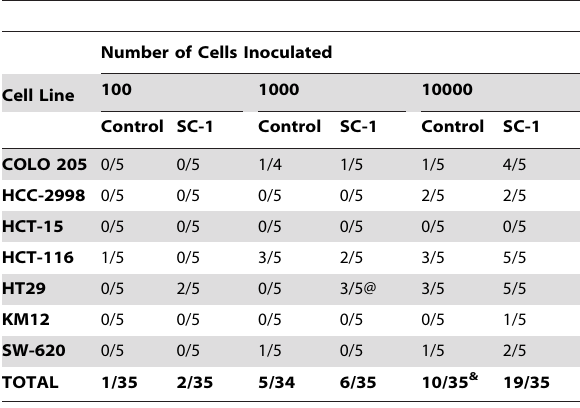
Table 1. Effect of SC-1 on the Tumor Take Rate of the Seven Colon Tumor Lines of the NCI60